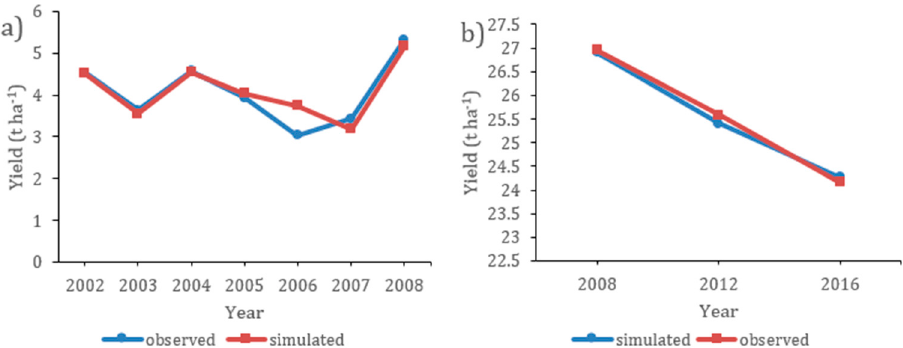
Figure 3. Validation of simulated data with ( a ) measured sole winter wheat grain yield (2002–2008) and ( b ) measured sole short rotation woody crop (SRWC) woodchips yield